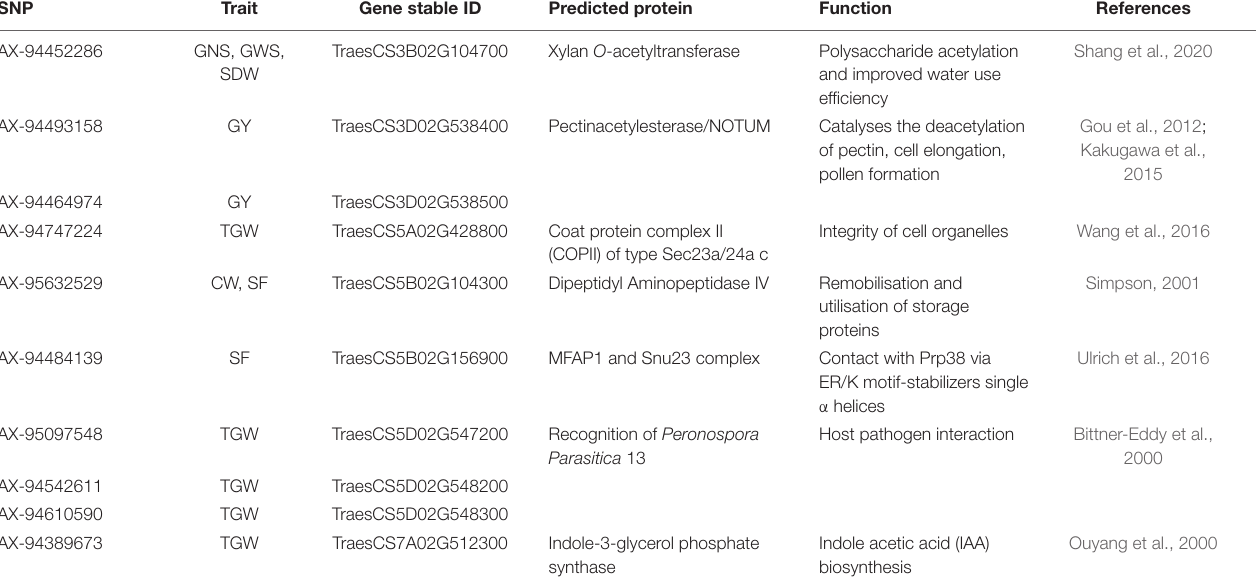
TABLE 1 | A list of predicted proteins translated by the IWGSC genes overlapping 10 novel SNPs. SNP Trait Gene stable ID Predicted